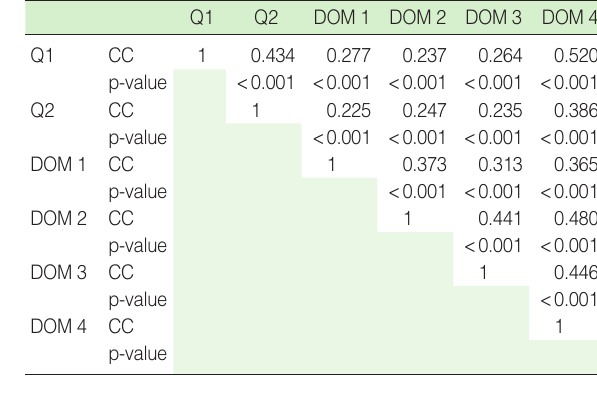
Table 2. Responses and missing items for each item (n = 300)